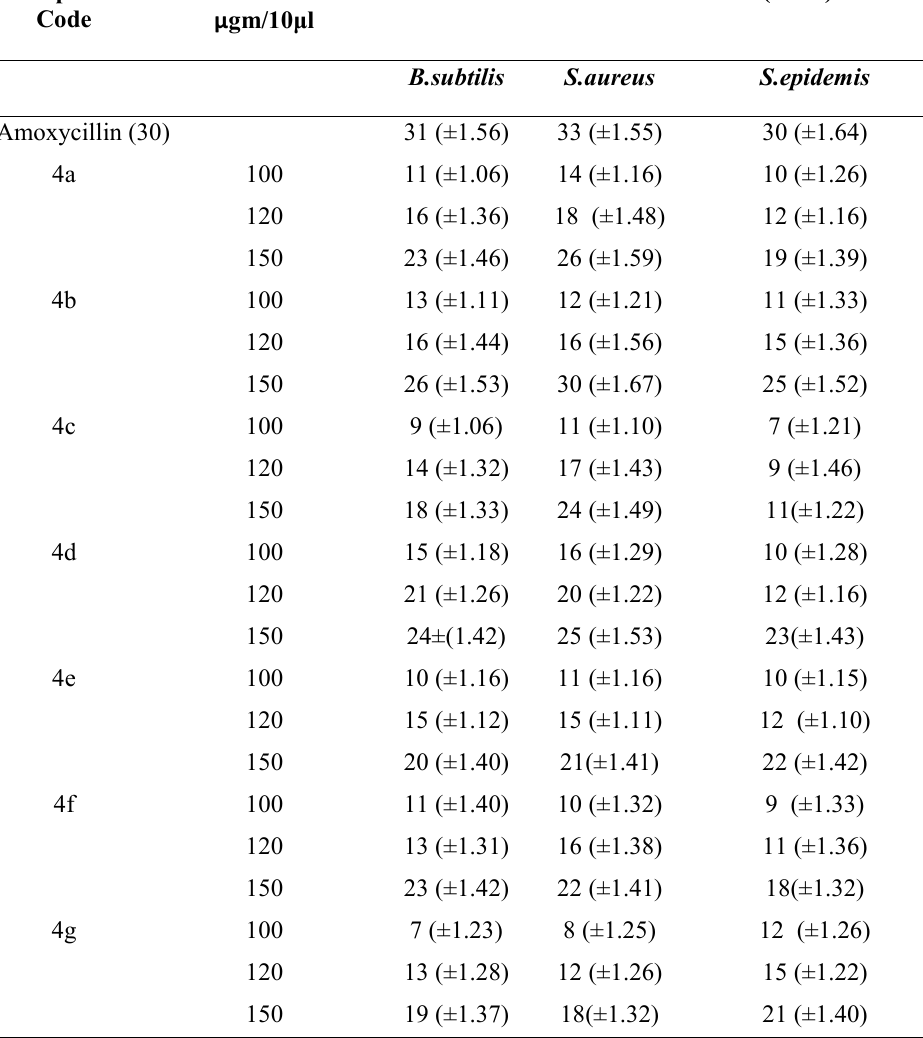
Table II. Zone of inhibition of synthesized compounds against gram positive